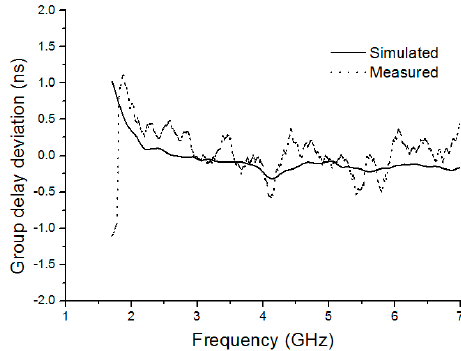
Figure 13. Simulated and measured group delay deviation of the proposed BRA.